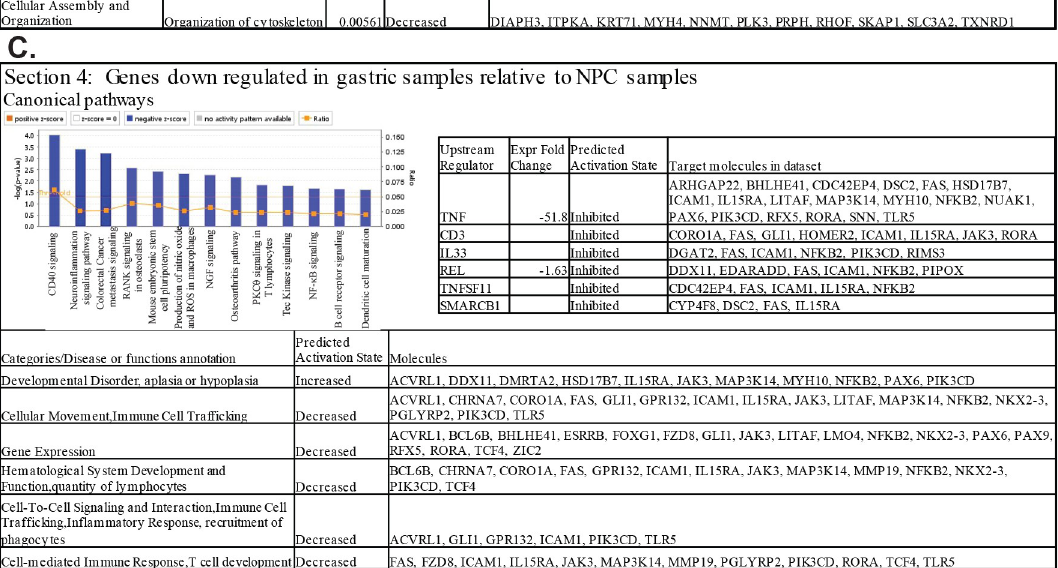
Fig 5. Analysis of canonical pathways, upstream regulators, and disease and functions within the annotated sections of the hierarchical clustering heat map. IPA analysis of the genes from 3 of the distinct areas on the hierarchical clustering heat map. (A)